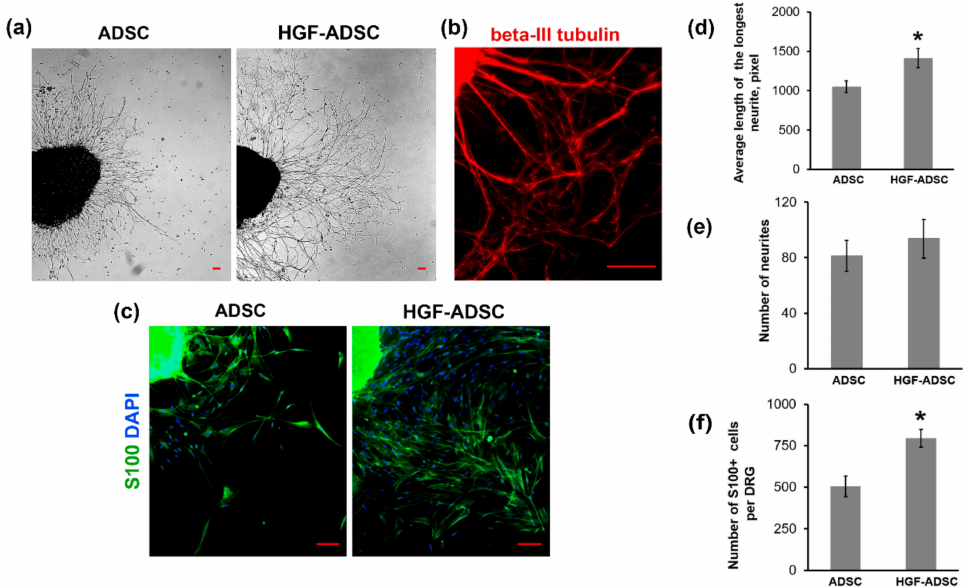
Figure 2. E ff ects of conditioned medium from HGF-producing or unmodified ADSC on neurites length and number of glial cells in dorsal root ganglion (DRG) explant model. ( a ) Phase-contrast DRG explant images; ( b ) immunofluorescence staining of DRG against beta-III tubulin; ( c ) representative immunofluorescence images of DRG explants stained against S100 (green) and DAPI (blue); ( d – f ) quantification of the average length of the longest neurite ( d ), number of neurites ( e ) and number of S100 + cells migrated from DRG explants ( f ). Data are presented as mean ± standard deviation (* p < 0.0001, Student’s t -test). Scale bar = 100 µ